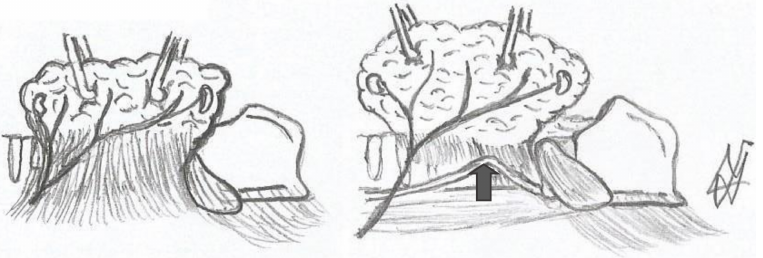
Figure 11. Thyroid, Berry’s ligament and the recurrent laryngeal nerve (drawing of the authors). The arrows show the